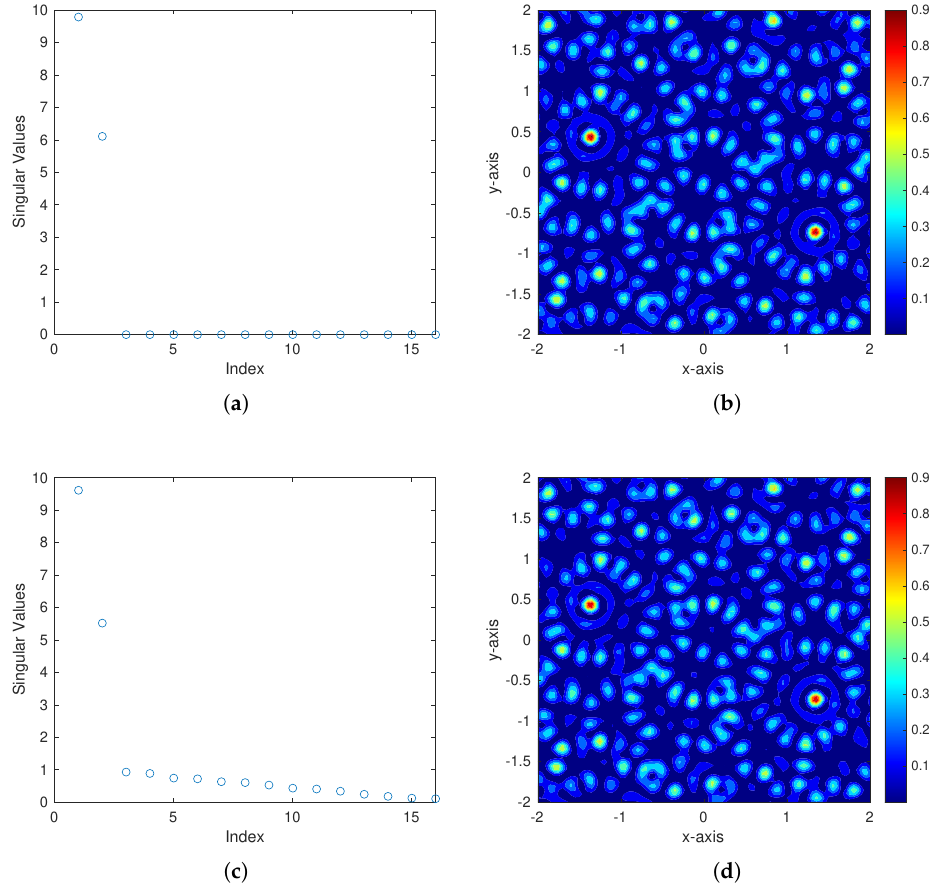
Figure 9. Singular value distribution and imaging results for randomly generated scatter’s data. ( a ) SVD with true data; ( b ) imaging result with true data; ( c ) SVD with learning data; ( d ) imaging result with learning